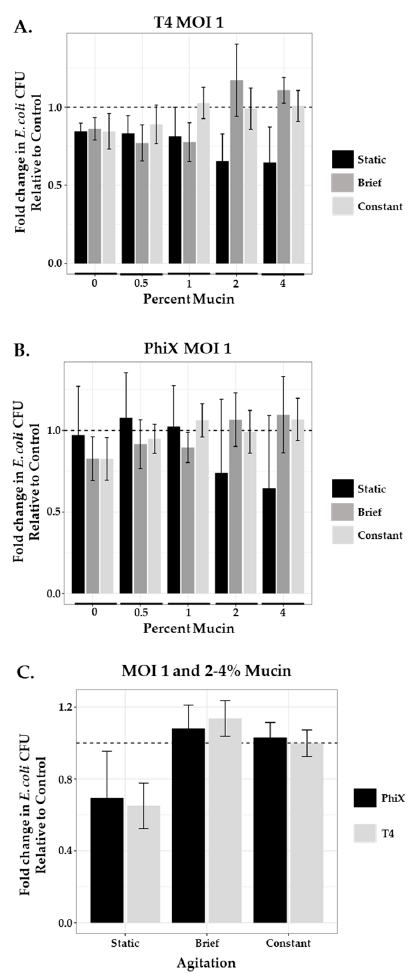
Figure 3. Agitation influences phage predation at high mucin concentration. Comparison of the fold change in bacterial growth as compared with controls (normalized to 1, dashed line) in static (black bars), briefly agitated (dark gray bars), and constantly agitated (light gray bars) in-tube samples of varying mucin concentration (0–4%) treated with MOI 1 of ( A ) T4 or ( B ) PhiX. Columns are means with 95% CI. ( C ) Comparison of the combined 2% and 4% mucin means of either PhiX-(black bars) or T4-(gray bars) treated samples after each type of agitation (static, brief, or constant). N ≥ 6 for all